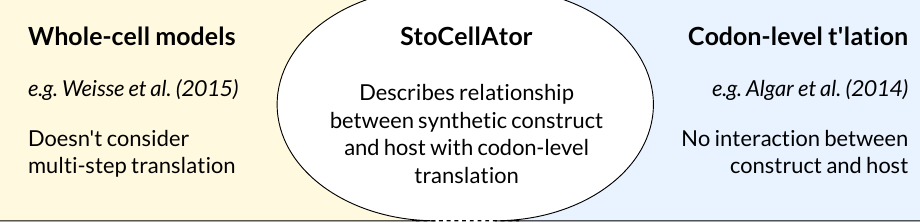
Figure 1. Our model combines codon-level translation with a resource-based whole-cell model, two components that have previously not been joined. In doing so, we see how the effects of ribosomal queues impact the relationship between synthetic construct expression and the dynamics of cell growth and heterologous protein expression and yields. StoCellAtor, stochastic whole-cell